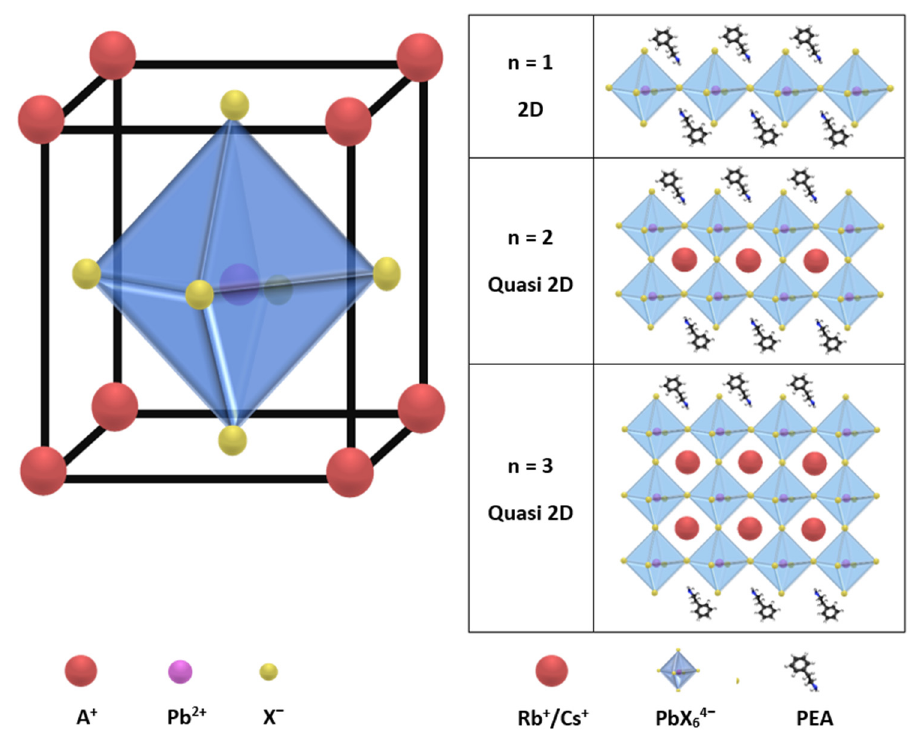
Figure 1. Schematic diagram of APbX 3 lead halide perovskite crystal structure ( left ); 2D and quasi-2D perovskite with n -values from 1 to 3 ( right ). Octahedra denote PbX 64- fragments, and small circles stand for Rb + or Cs + ions, whereas PEA is indicated by its molecular shape.